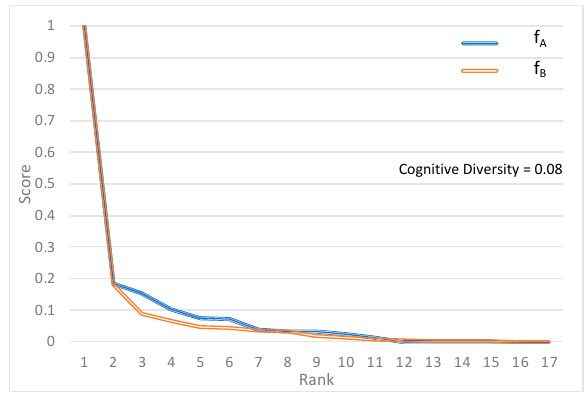
Figure 1. Rank-score functions f A and f B for low cognitive diversity case [30].